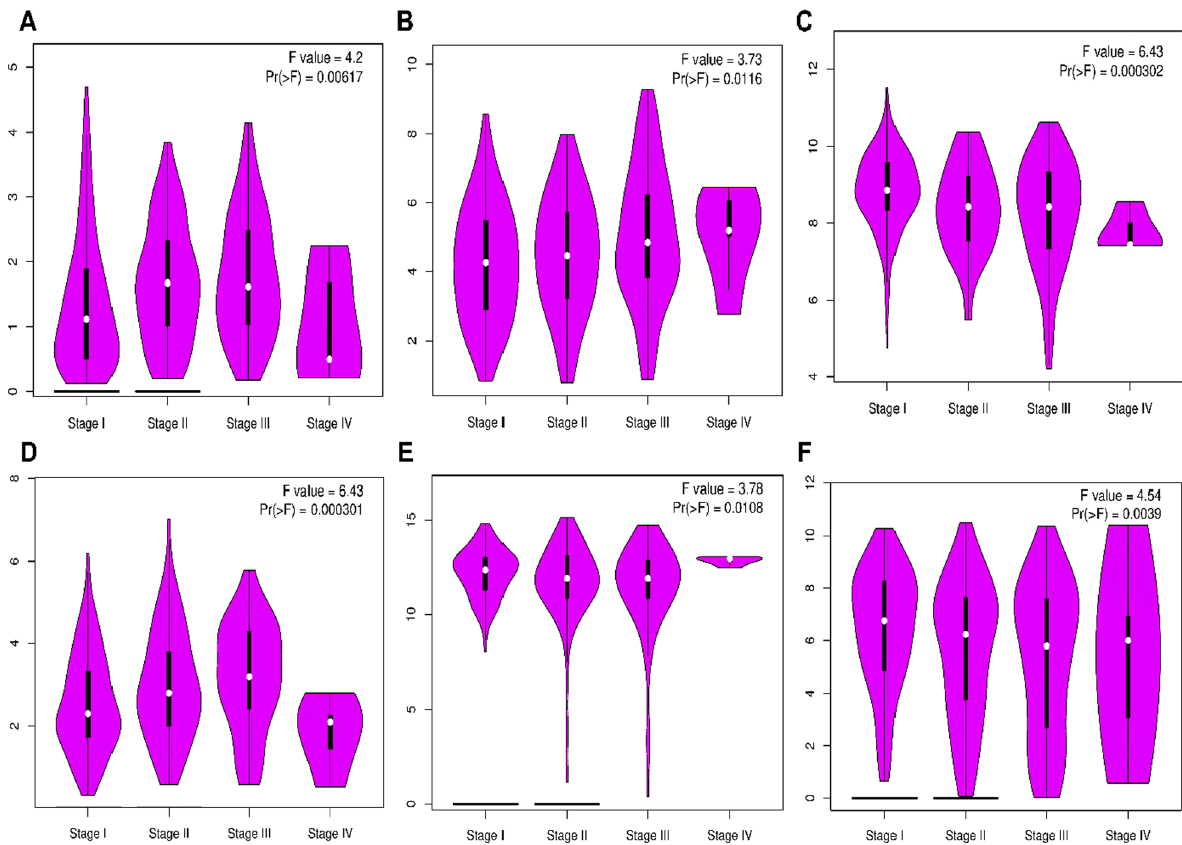
Fig. 4 Violin plots displaying association between significant TNM stages and A APLN, B SERPINE1, C ALDH2, D E2F1, E ORM1, F PCK1 across TCGA-HCC cohort. The black-colored bars and white-colored dots signify interquartile ranges and median, respectively. The ordinate and abscissa depict expression levels of these key genes and various